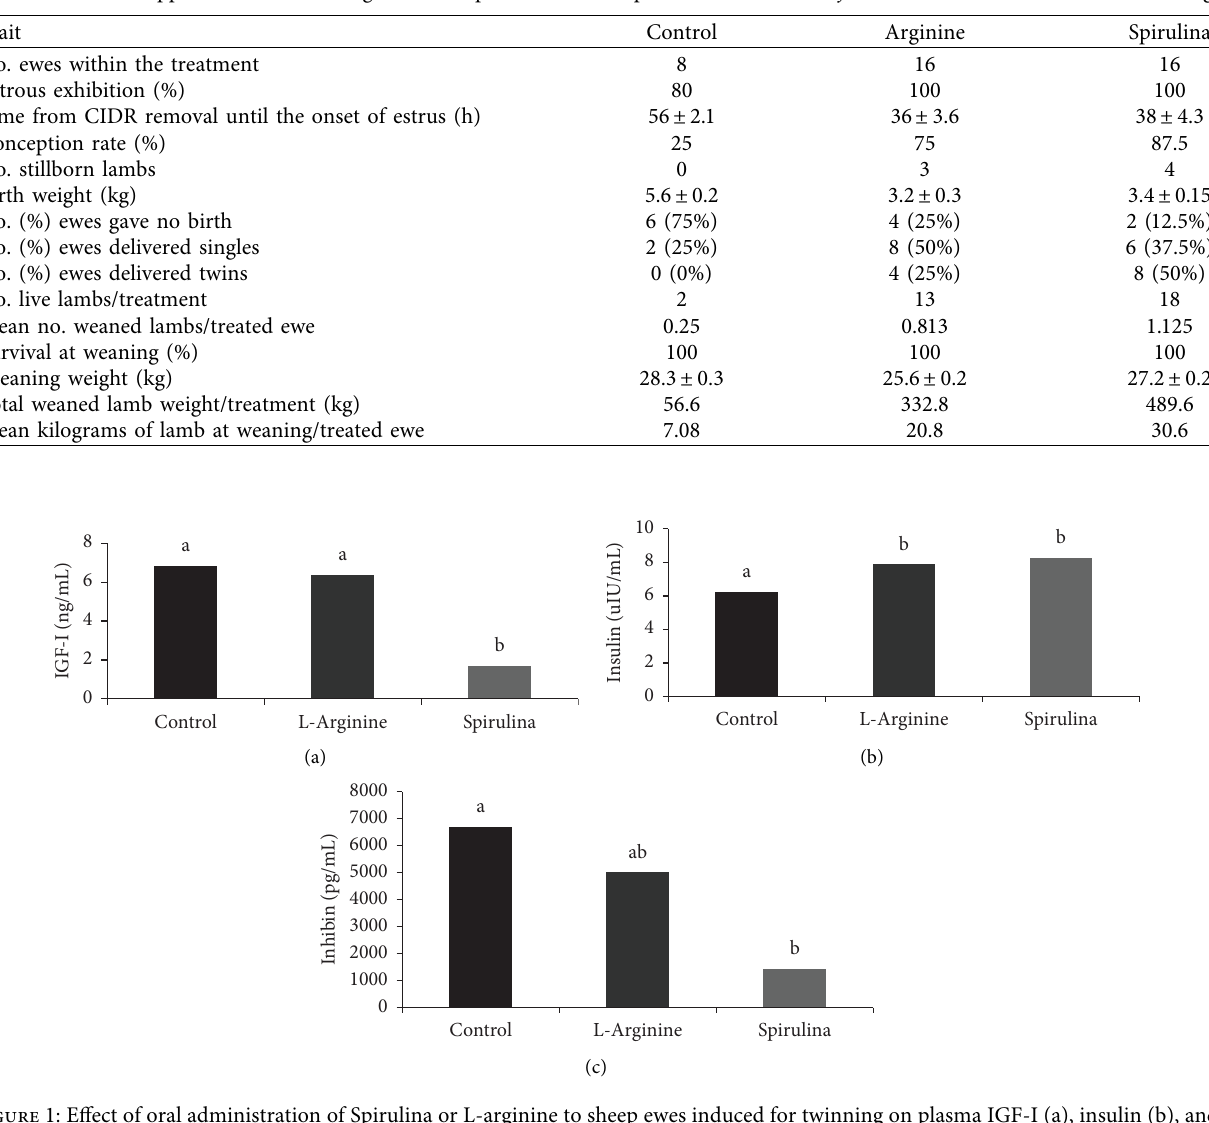
Figure 1: Efect of oral administration of Spirulina or L-arginine to sheep ewes induced for twinning on plasma IGF-I (a), insulin (b), and inhibin (c). ( a , b P < 0 . 05).